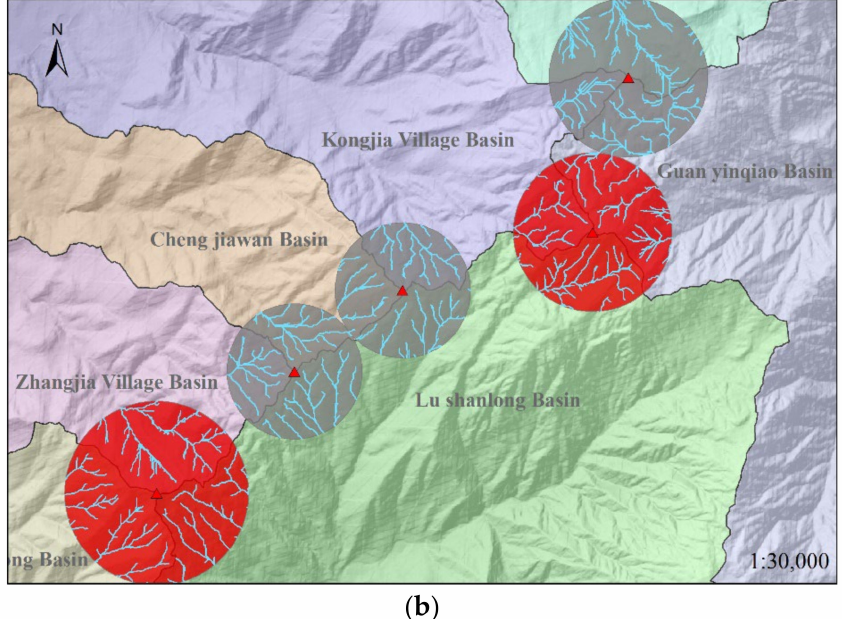
Figure 12. The identification result of RD. ( a ) The identification result of RD in the whole of Mount Lu. ( b ) The local identification results.